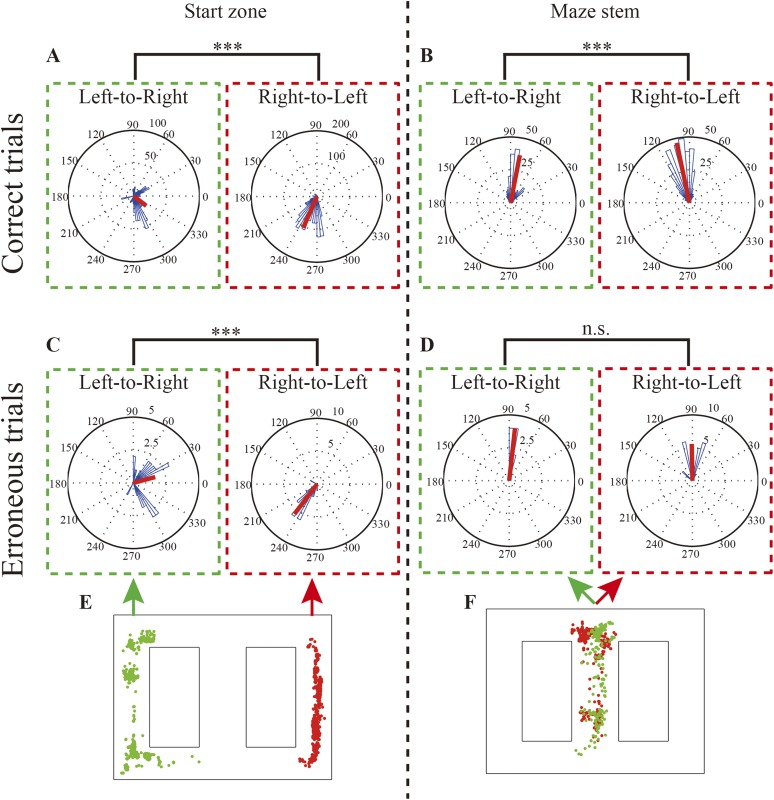
Rats' head direction during replays and replay location.(A, B) Rose diagrams of rats' head directions in replays occurring during left-to-right and right-to-left journeys in the start zone (A) and within the maze stem (B) in correct trials. (C, D) as for (A, B) but for erroneous trials. Occurrence locations are organized in two columns. In each column, green and red dotted lines enclose left-to-right and right-to-left journeys, respectively. (E, F) Physical locations where the replays occurred (green dots: left-to-right journeys; red dots: right-to-left journeys). Note that circular medians (red bars) were oriented toward a memory-guided goal (i.e., a goal opposite to the current location), except in replays occurring in the maze stem during erroneous trials. The head directions during delay periods in the DA subtask within the maze stem were excluded. ***: p < 0.0001, n.s: p > 0.05.